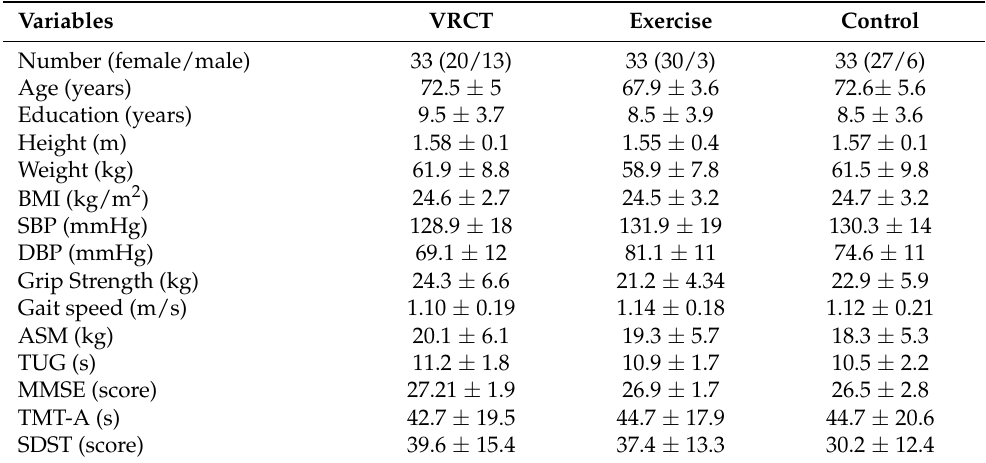
Table 2. The baseline anthropometric, physical, and cognitive function characteristics of the participants. Variables